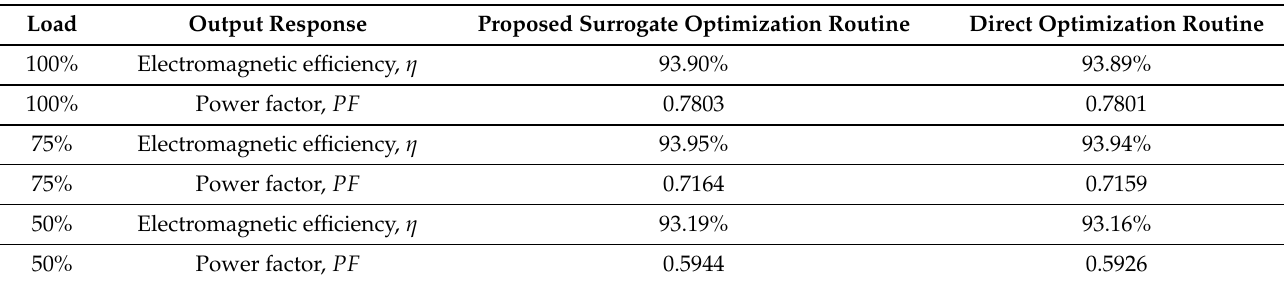
Table 18. Comparison of electromagnetic efficiency and power factor for various load points of the optimal design— proposed surrogate optimization routine vs. direct optimization routine.